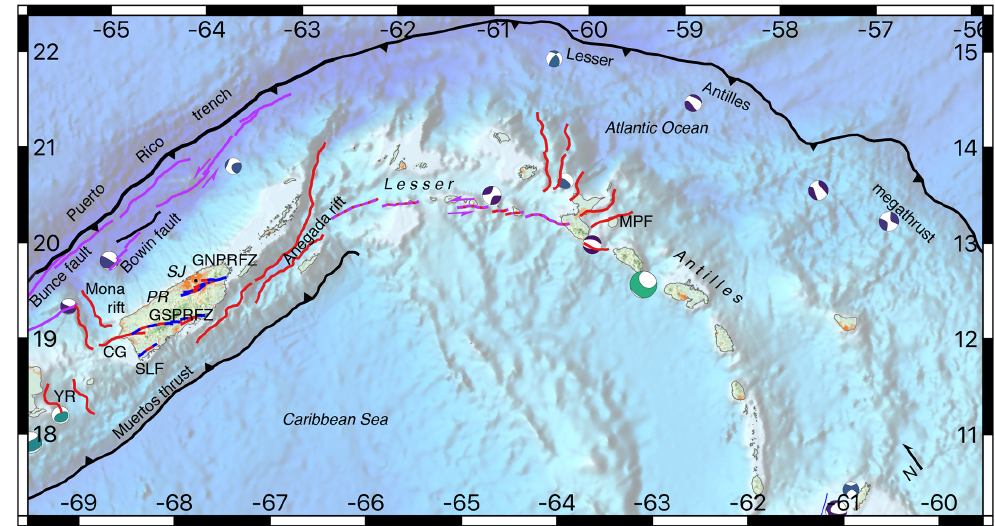
Figure 8. Active faults of the Lesser Antilles. YR is the Yuma rift. CG is the Cerro Goden fault. SLF is the southern Lajas fault. GSPRFZ is the great southern Puerto Rico fault zone. GNPRFZ is the great northern Puerto Rico fault zone. MPF is the Morne Trois Pitons fault. SJ is San